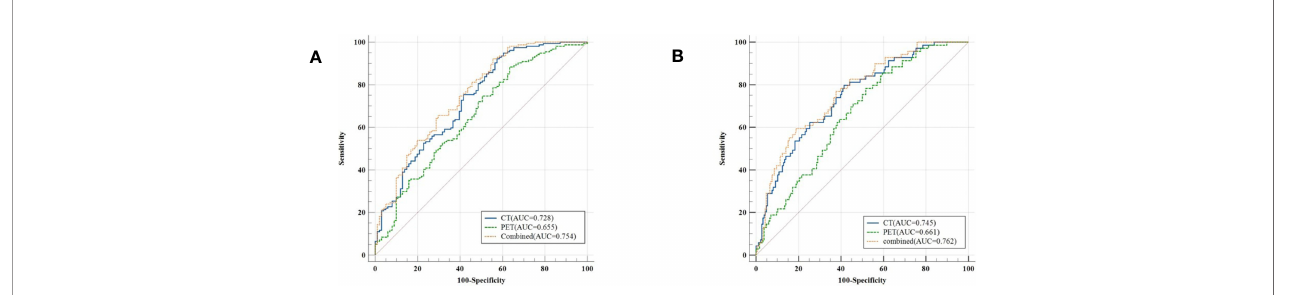
FIGURE 4 | Classi fi ers ’ performance on predicting the expression status of PD-L1 based on three models (CT, PET, and the combined model). Classi fi ers ’ performance on predicting 1% level of PD-L1 (A) . Classi fi ers ’ performance on predicting 50% level of PD-L1 (B) .